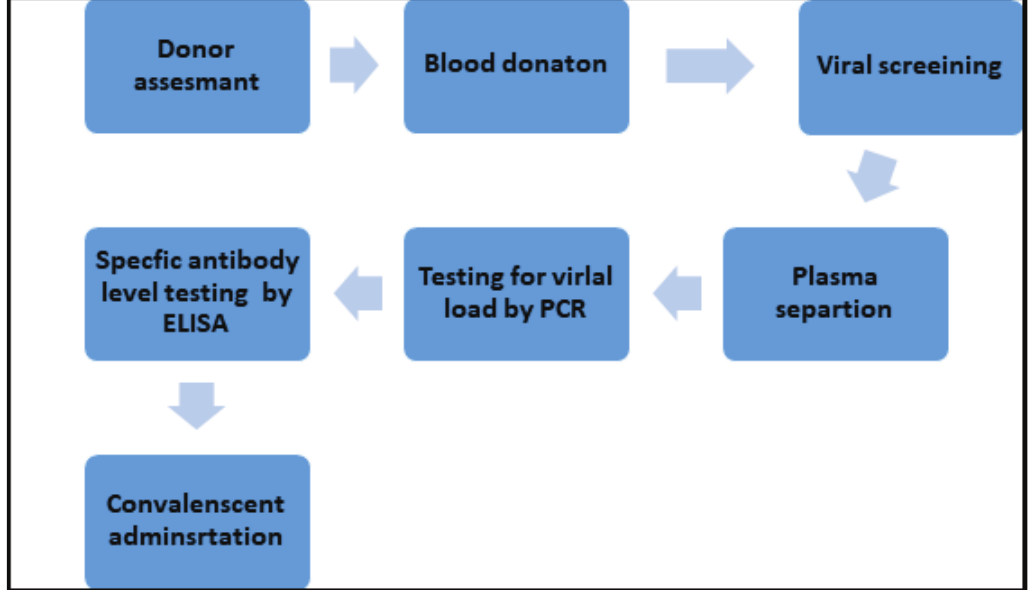
Figure 3: flow chart of convalescent plasma preparation in covid-19 patients showing the major steps from donor selection to the administration of screened plasma units. PCR: Polymerase chain reaction. ELISA: enzyme-linked immunosorbent